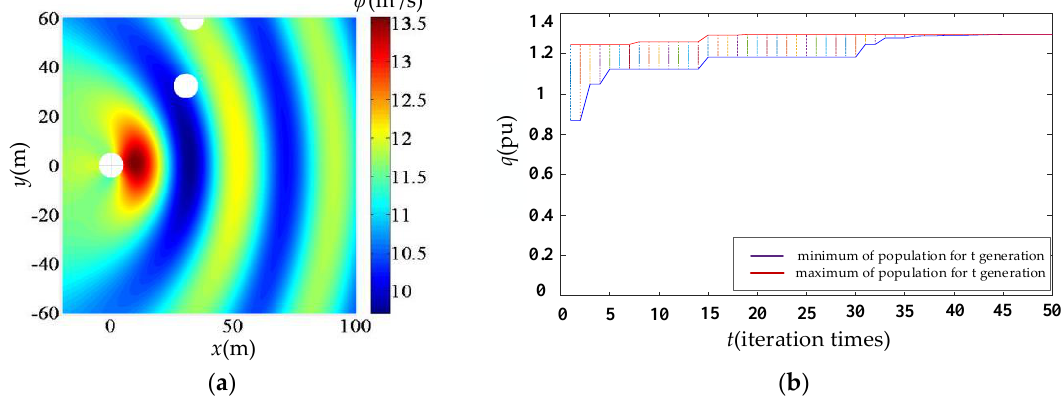
Figure 11. Optimal results for the three-float array under the traditional DE algorithm: ( a ) the optimal position; ( b ) individual fitness values for each generation. Table 5. Energy capture coefficient of the WEC array under the traditional DE algorithm ( N = 3).